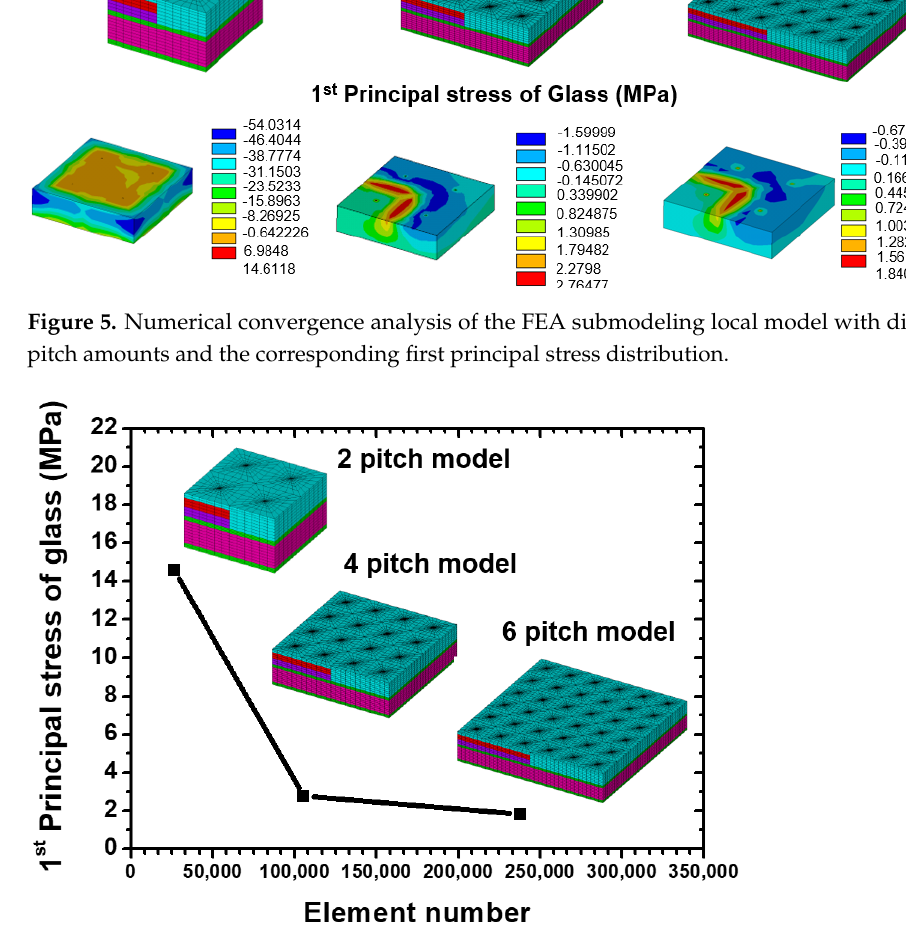
Figure 6. Maximum first principal stress of glass of local models with different via pitch amounts and element numbers.